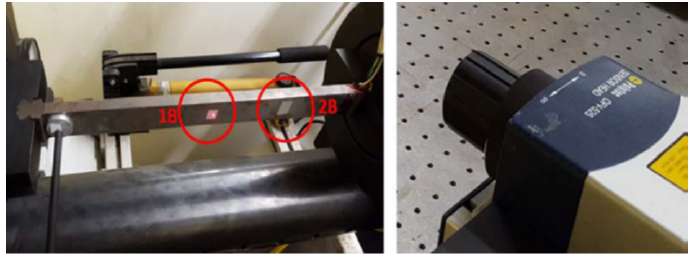
Figure 4. Laser pointer (1B) and velocity measurement (2B) spots.